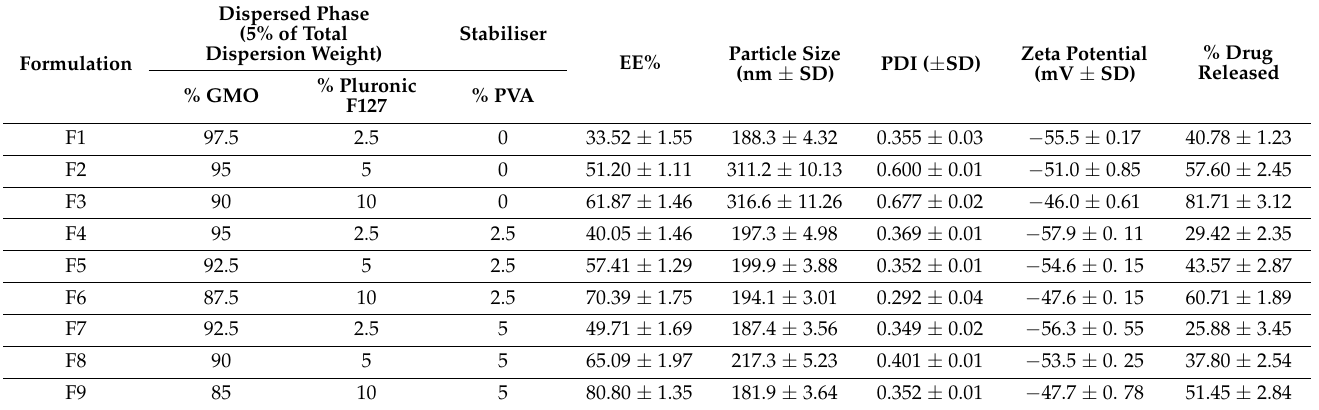
Table 1. Composition and characterisation of different formulations of SIM-loaded